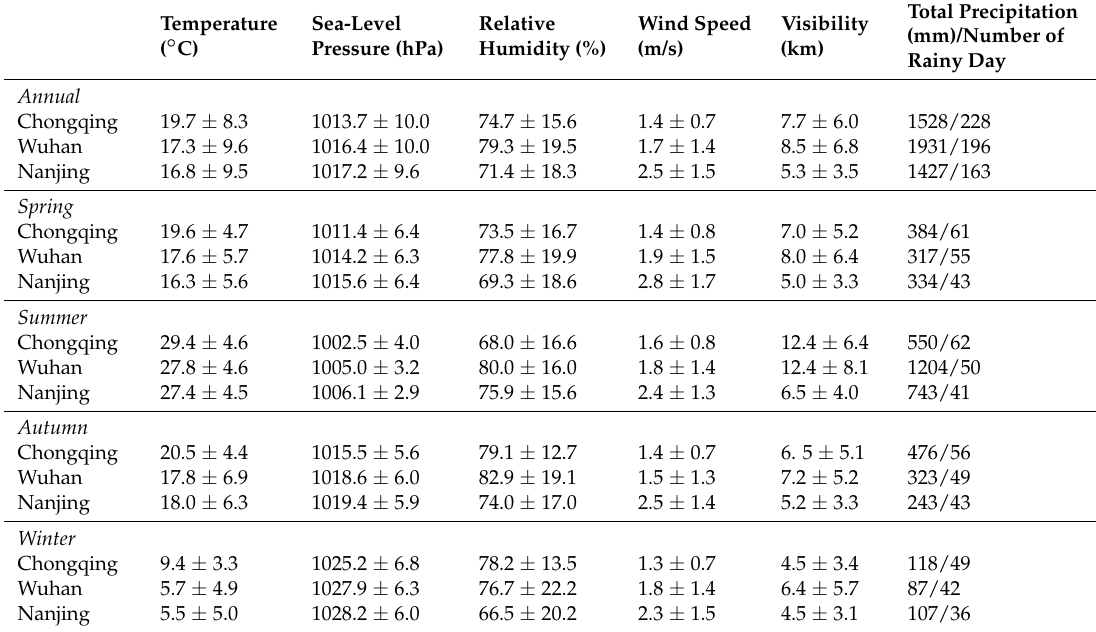
Table 3. Annual and seasonal mean values with standard deviations of meteorological parameters in Chongqing, Wuhan, and Nanjing,